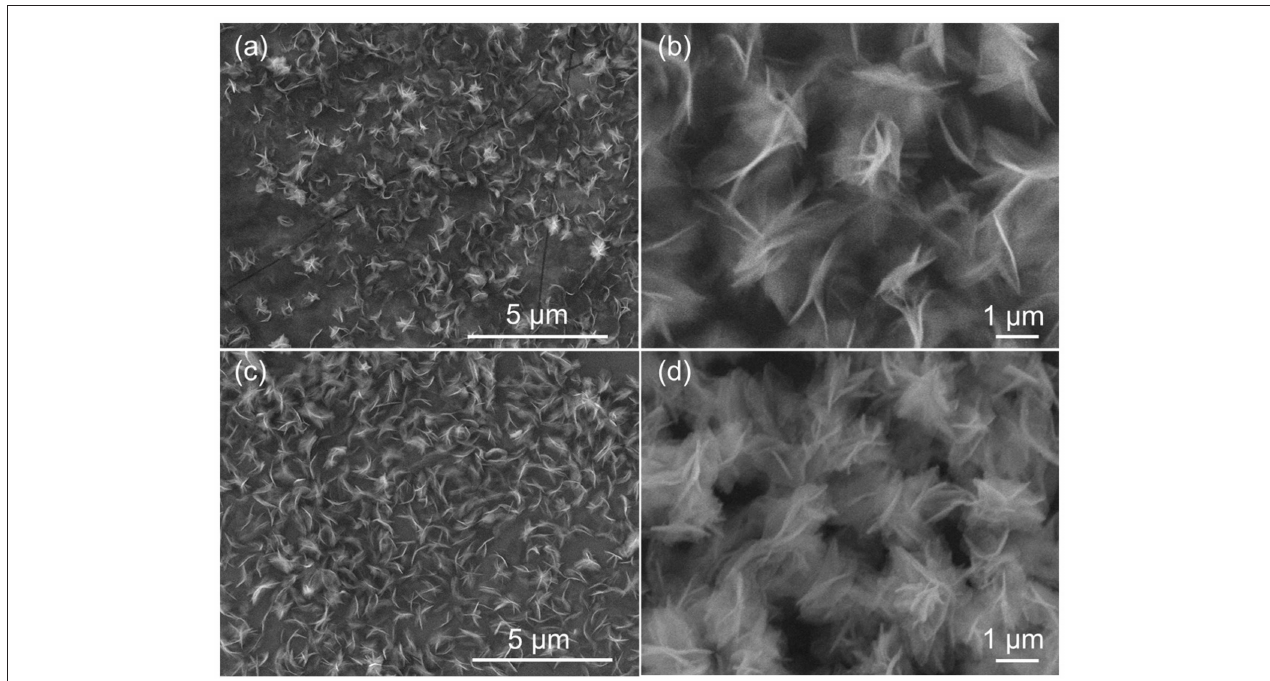
FIGURE 2 | SEM images of the as-prepared (a,b) γ -AlOOH, (c,d) γ -AlOOH/Fe(OH) 3 micro/nanoflowers.